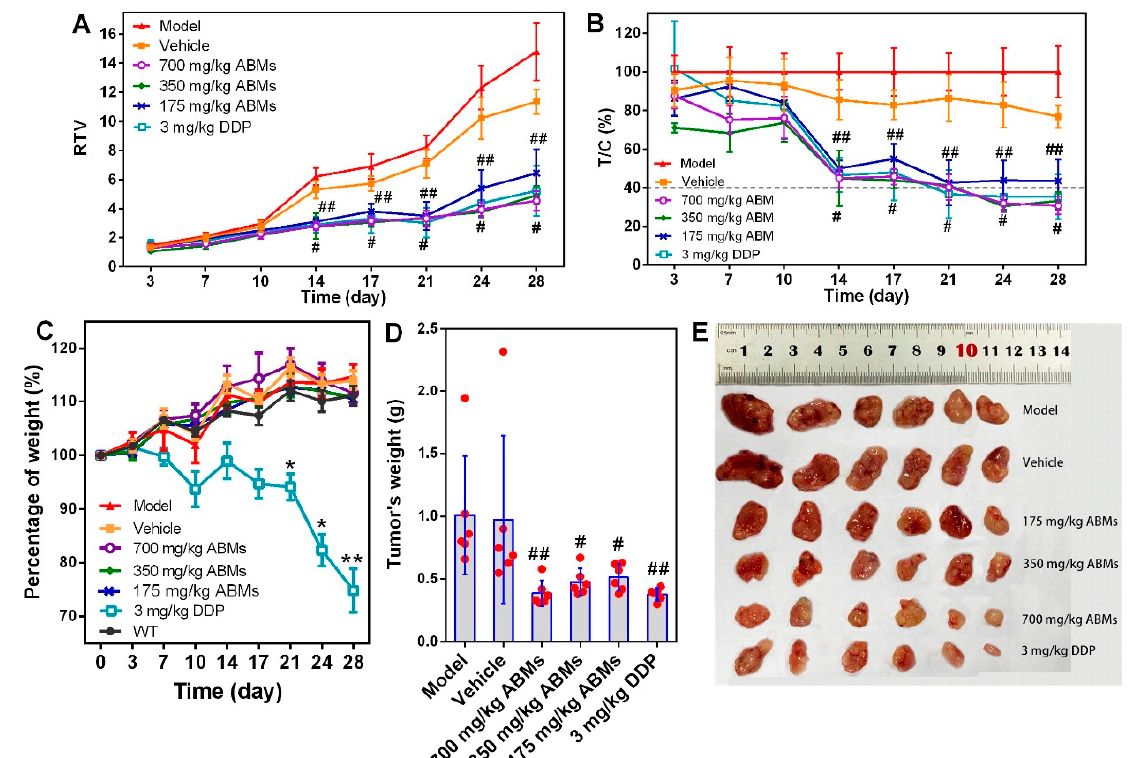
Figure 8. Diagrams of in vivo pharmacodynamics. ( A ) Results of relative tumor volume change over time in tumor-bearing mice within 28 days; ( B ) T/C (%) change result of tumor-bearing mice relative tumor growth rate within 28 days; ( C ) Results of body weight changes over time in different tumor-bearing mouse groups; ( D ) Tumor weights of different tumor-bearing mice groups; ( E ) Diagram of tumor size at the site of inoculation after the experiment in different tumor-bearing mouse groups ( n = 6). Note: A&B, # p < 0.05, vs. vehicle group; ## p ≤ 0.001, vs. Model group; * p < 0.05, vs. WT group; ** p < 0.01, vs. WT group. All numerical results were denoted by mean and